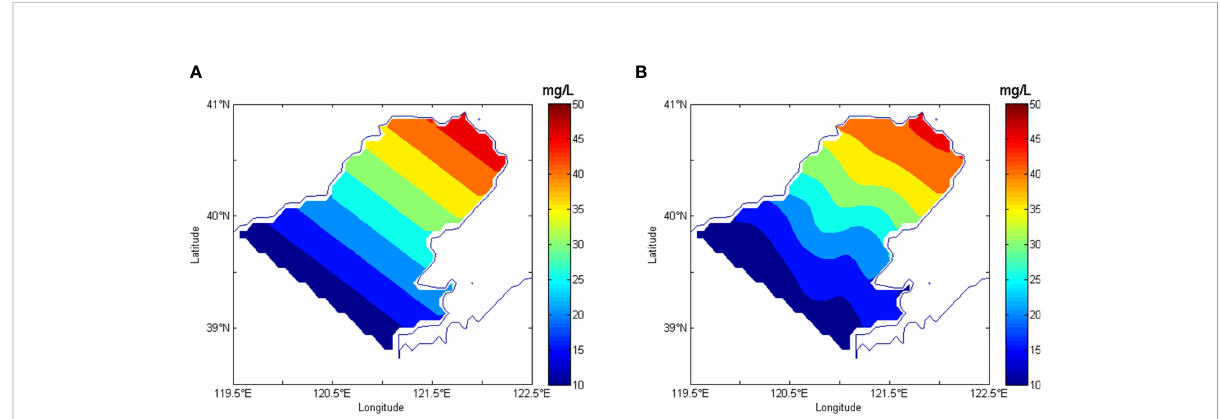
FIGURE 4 Interpolated results of given initial distribution of SPM that increases uniformly with the distance from the mouth. (A) is the given initial distribution in Ideal Experiment II. (B) is interpolated distribution derived from dynamically constrained interpolation. The observations using in the interpolation were picked up from the model-generated concentrations based on given distributions.